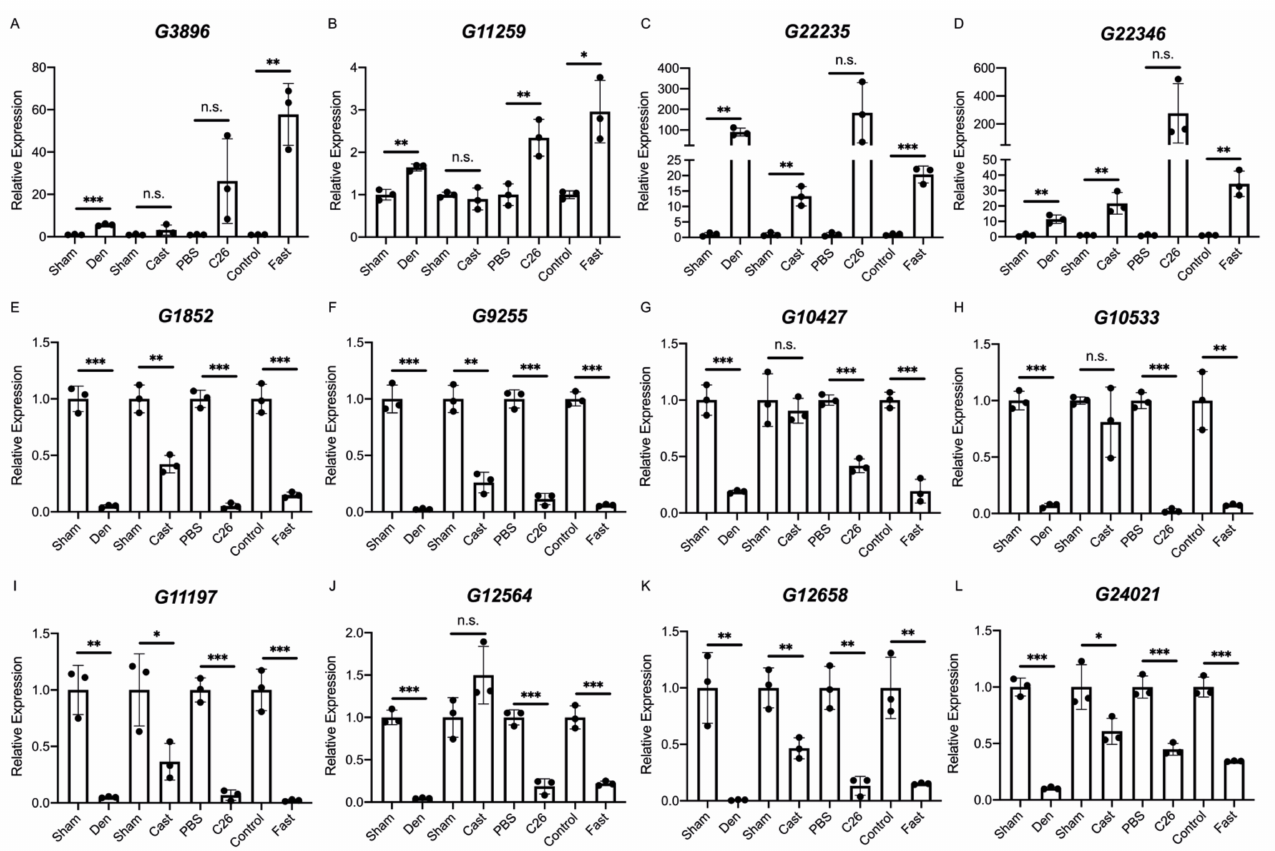
Figure 7. Changes in the expression of unannotated lncRNAs in four muscle atrophy conditions. ( A – L ) The qRT-PCR results for G3896 ( A ), G11259 ( B ), G22235 ( C ), G22346 ( D ), G1852 ( E ), G9255 ( F ), G10427 ( G ), G10533 ( H ), G11197 ( I ), G12564 ( J ), G12658 ( K ), and G24021 ( L ) in four muscle atrophy conditions. Data were normalized to Rpl26 expression and are shown as relative expression. n = 3 per group, mean ± SD. Dots represent the value of each sample. * p < 0.05; ** p < 0.01; *** p < 0.001; n . s , not